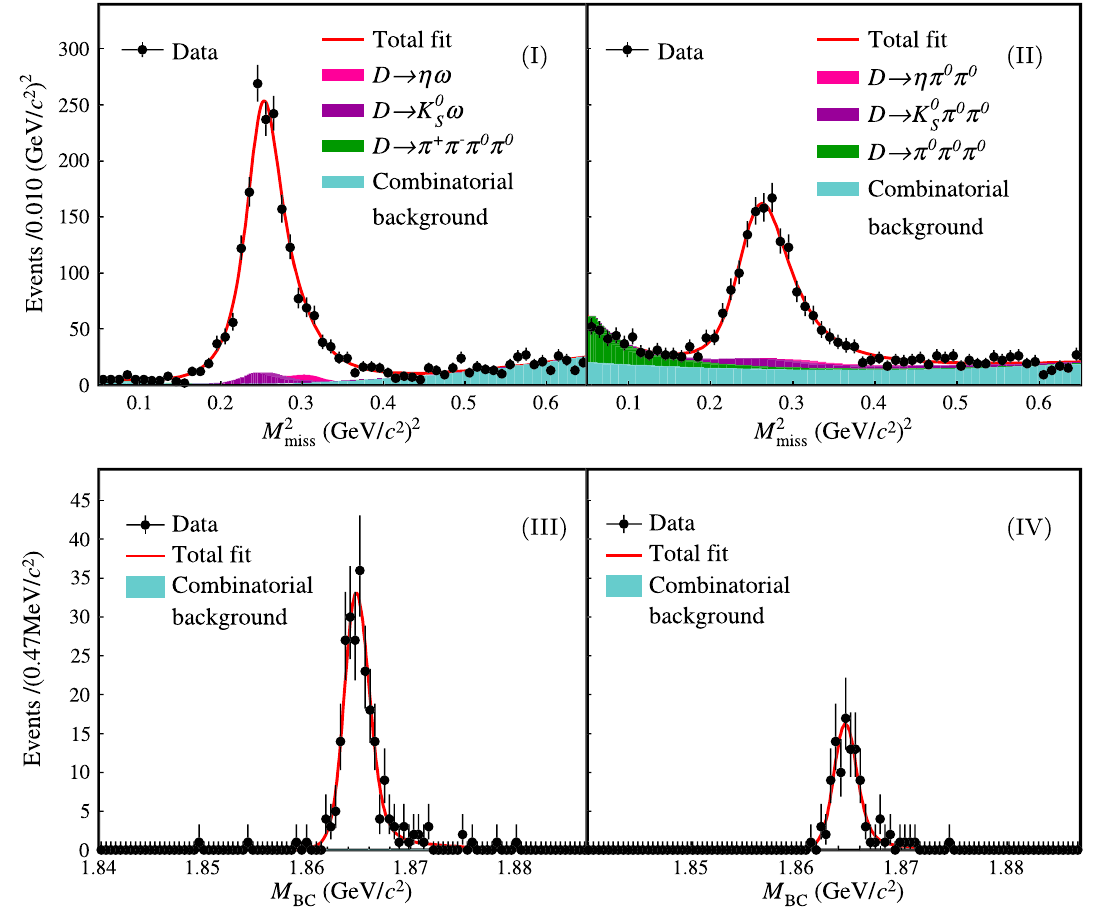
ω (I) and D → K 0 π 0 π 0 (II) modes, and M L L φ (IV) modes S